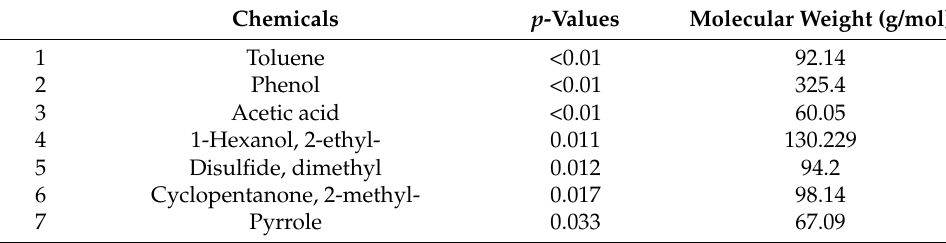
Table 5. List of possible biomarkers from the analysis of urine samples by GC-TOF-MS identified using PubChem, NIST and publications significant to PCa.